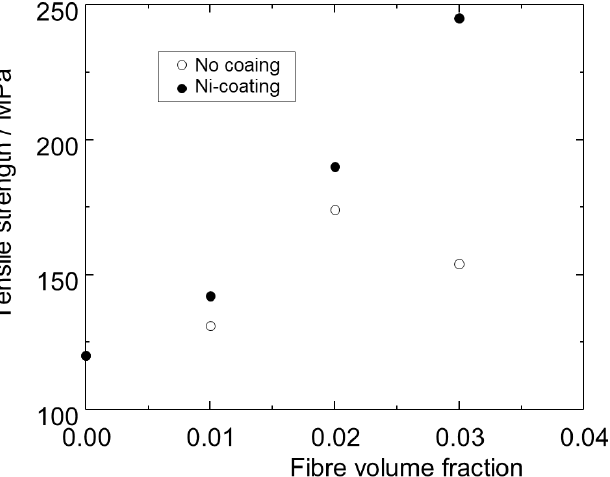
Figure 7. Strength of short- carbon-fibre/aluminium-matrix composites versus the fibre volume fraction. After experimental data published in [27].